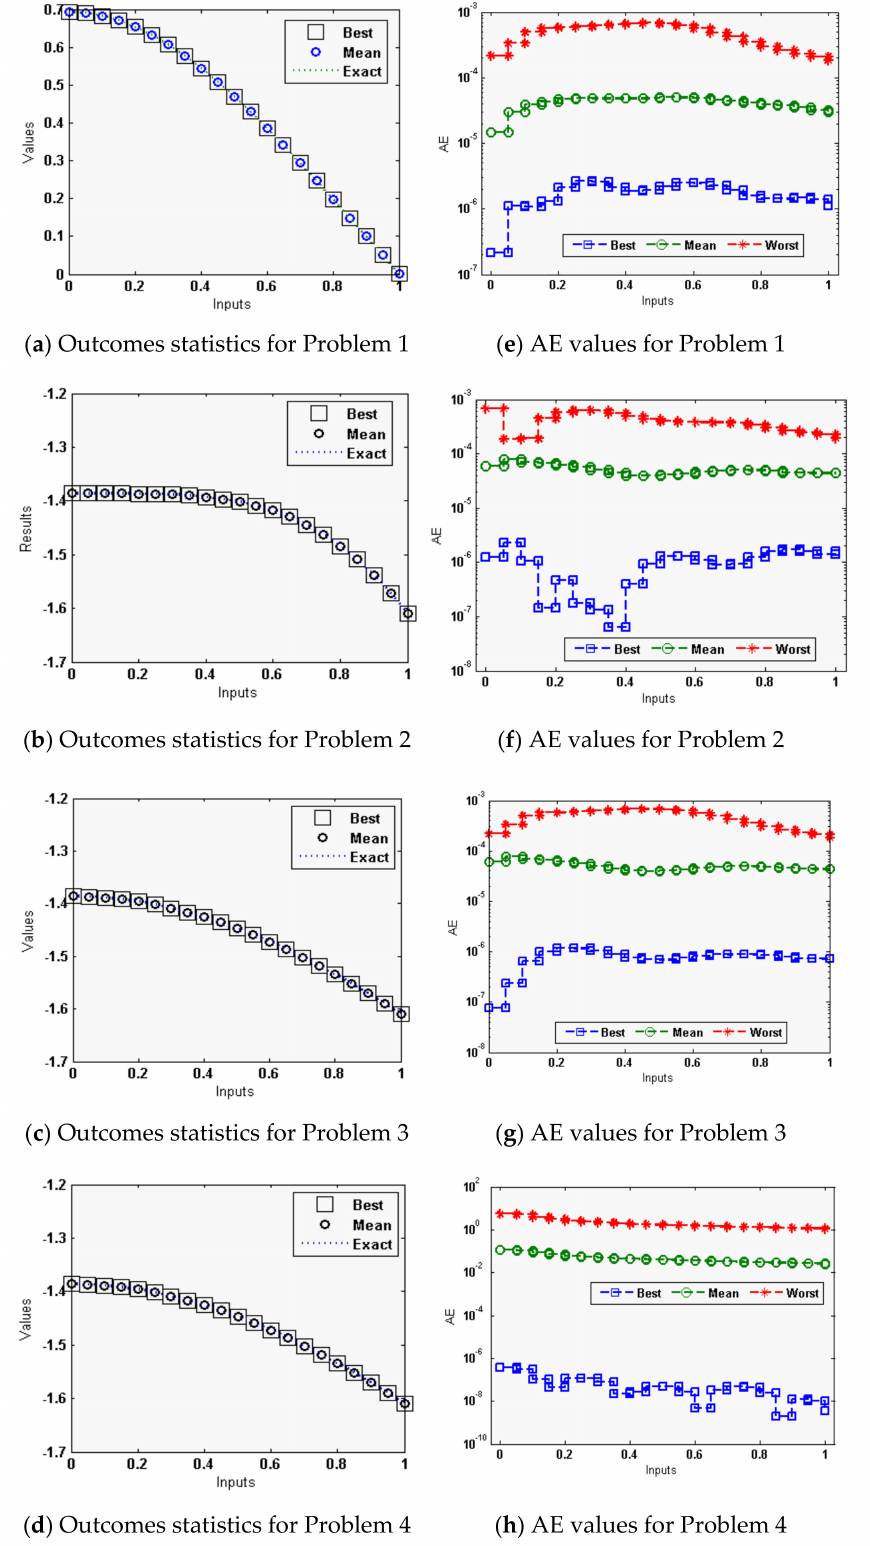
Figure 2. Comparison of results along with the AE through ANN-GA-SQPM to solve the singular model of Lane–Emden type. ( a – d ) for the solution dynamics, while ( e – h ) for